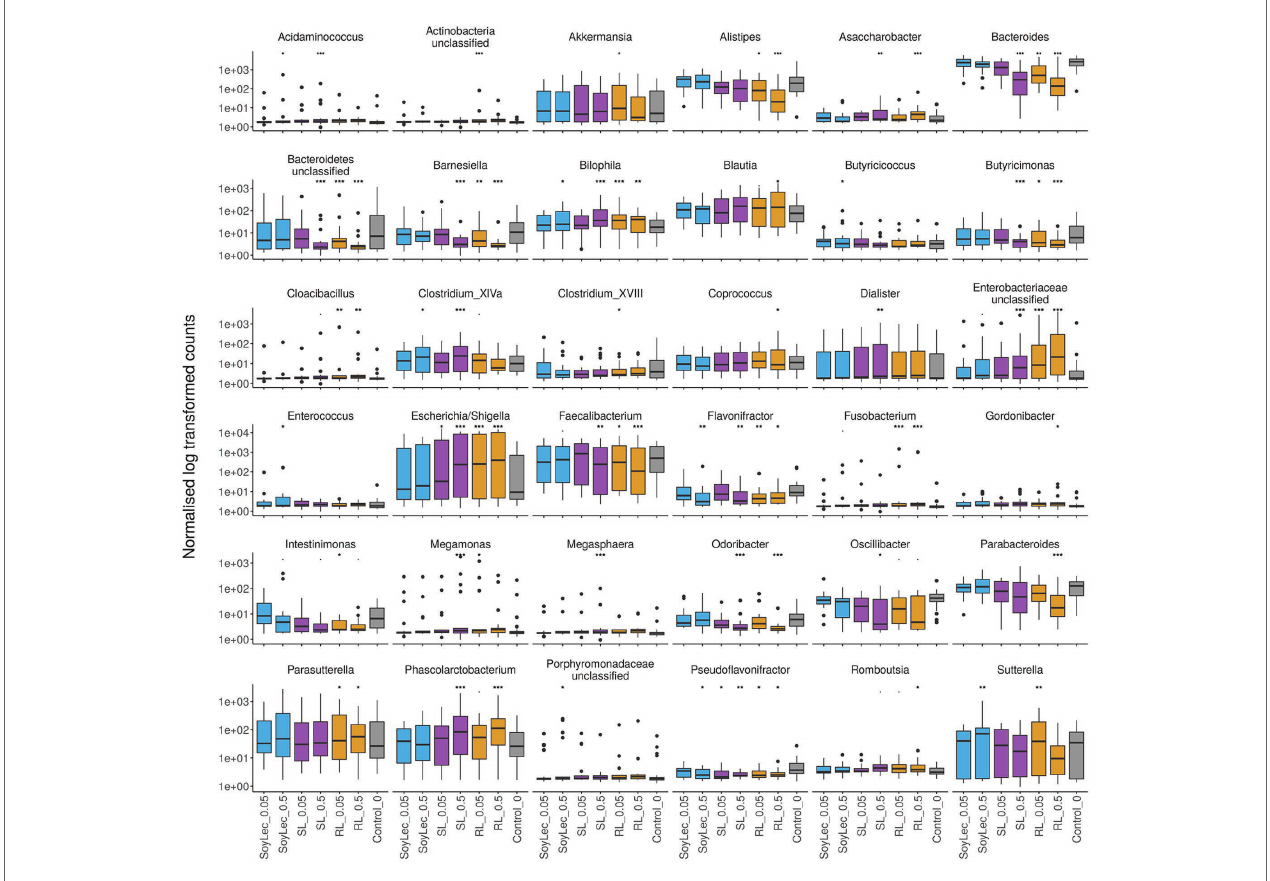
FIGURE 6 | Copy number corrected counts of significantly increased or decreased genera, obtained from DESeq analysis in R (version 3.4.2), after 48 h of exposure of gut microbial communities from 10 donors to soy lecithin, sophorolipids, and rhamnolipids during in vitro batch incubations. Asterisks represent significant differences with the control based on Wald tests ( α =